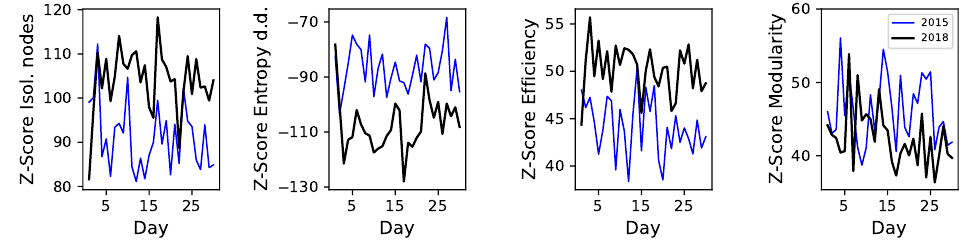
Figure 7. Comparing executed operations in September 2015 and 2018. Each panel depicts the evolution of a network metric for the years 2015 (blue lines) and 2018 (black lines), as a function of the day of the month—see Figure A10 for a complete analysis of the 2015 networks.